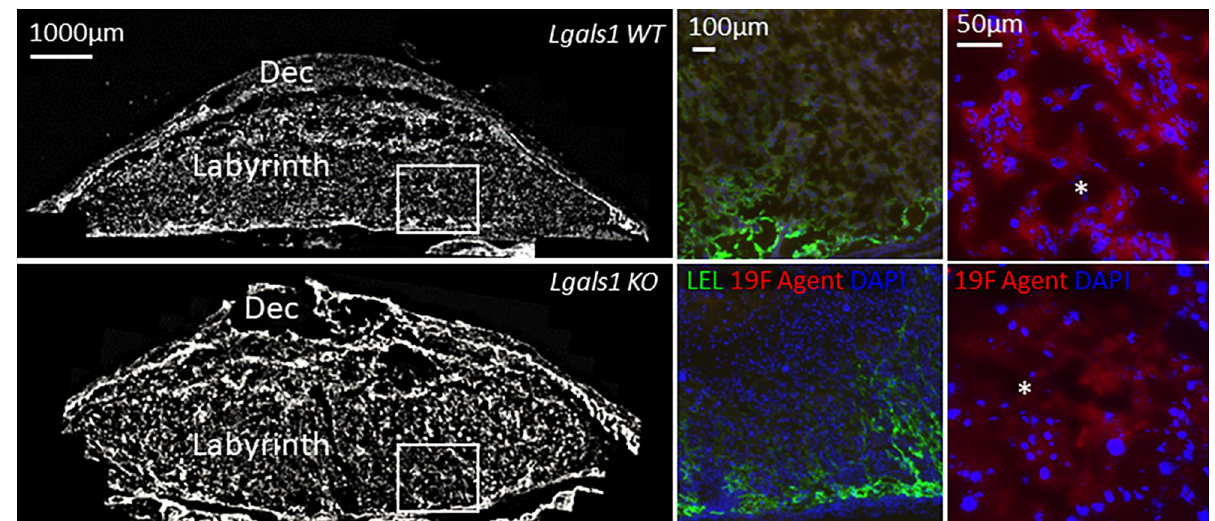
Figure 4. Representative placental histology images derived from Lgals1 WT (upper) and Lgals1 KO (lower) showing the decidua (Dec) and placenta layers including the Labyrinth. 19 F Agent (red) was found in both maternal and fetal blood spaces. Fetal circulation is denoted by the asterisks inserts in both Lgals1 WT (upper) and Lgals1 KO ( lower). DAPI counterstained nuclei and DyLight 488 labeled Lycopersicon Esculentum (Tomato) Lectin (LEL) was used for imaging vascular structures (endothelial cells). Bars indicate 1000 µm, 100 µm and 50 µm respectively.